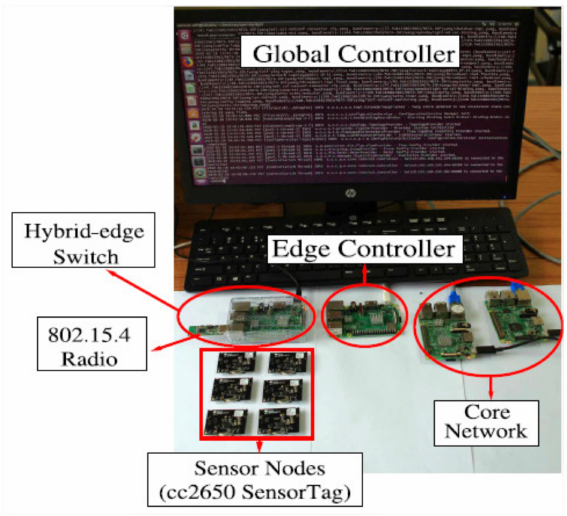
Figure 2. Example of scenario with network control distributed in SDN